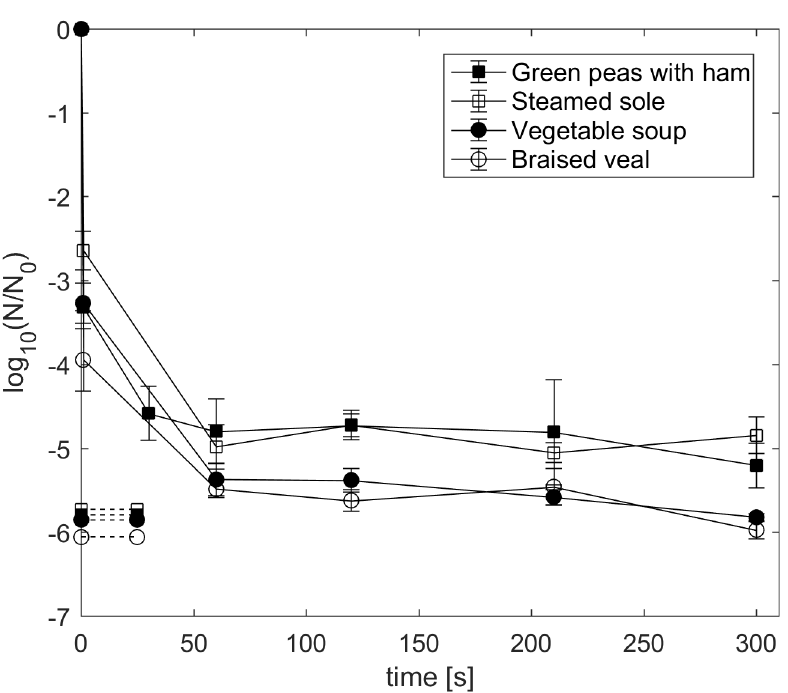
Fig 2. Log reduction of C . botulinum TMW 2.357. Spores suspendedin green peas with ham (solid squares), steamed sole (open squares), vegetablesoup (solid circles) and braised veal (open circles) after HPT treatment at 600 MPa and 110˚C for 1 to 300 s. Dashedlines indicatethe corresponding detection limits. Initial spore count: 10 7 spores/g. Data are shown as means ± standarddeviationsof triplicate independent